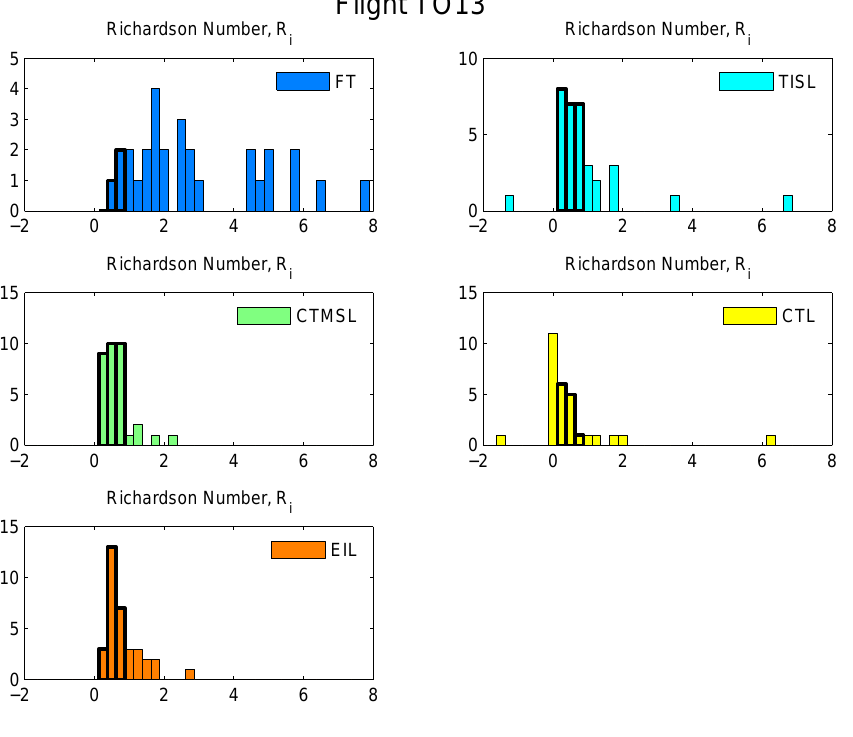
Fig. 15. As in Fig. 14, but for flight TO13.